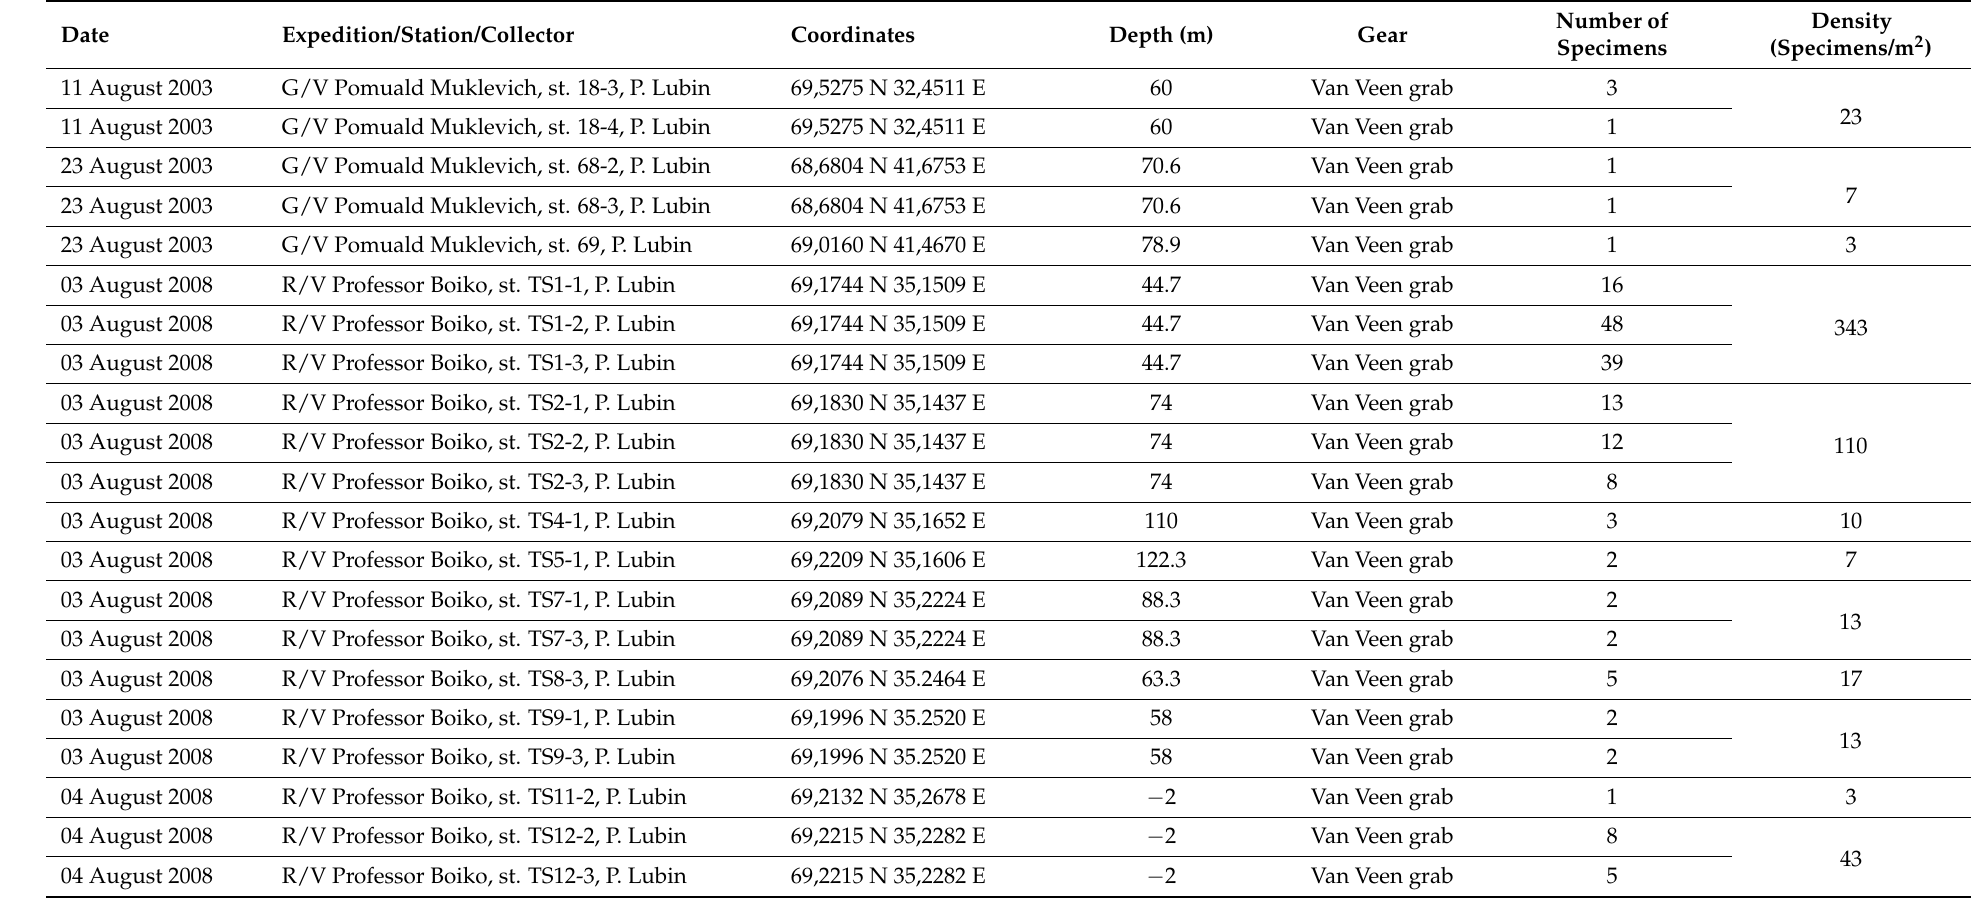
Table 1. Sites of sampling of the examined specimens of Philinissima denticulata comb. nov. from the White and Barents